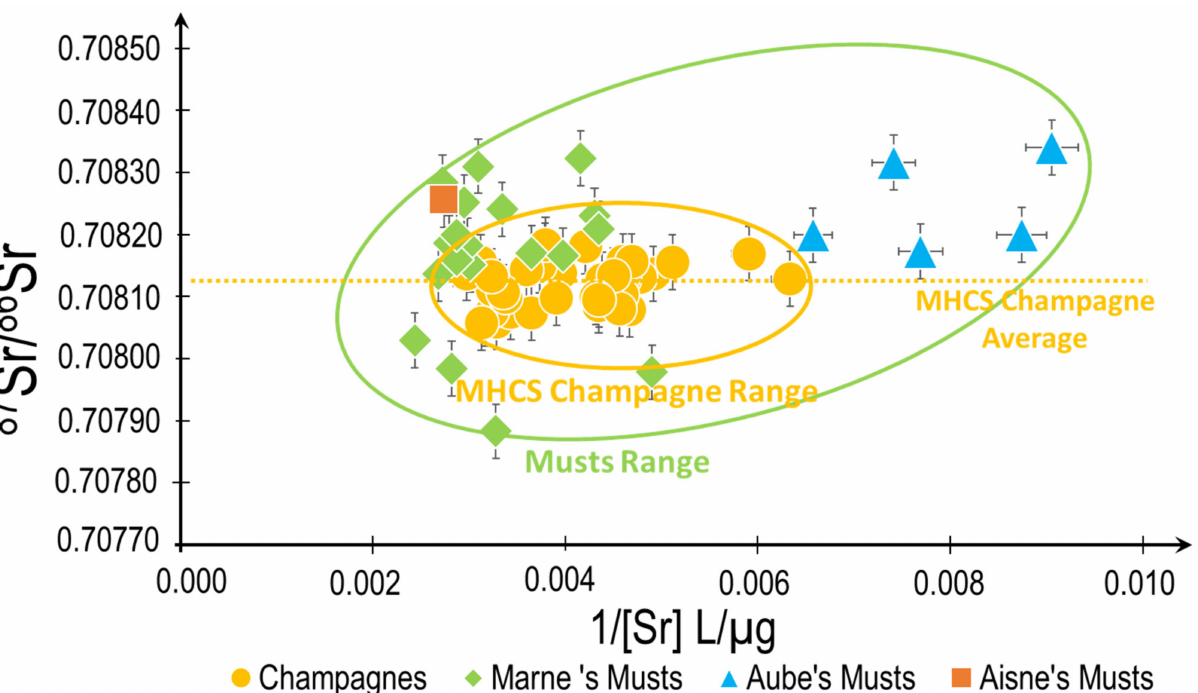
Figure 6. Sr isotopic biogeochemical mixing model applied to musts produced at specific locations in the Champagne AOC area and